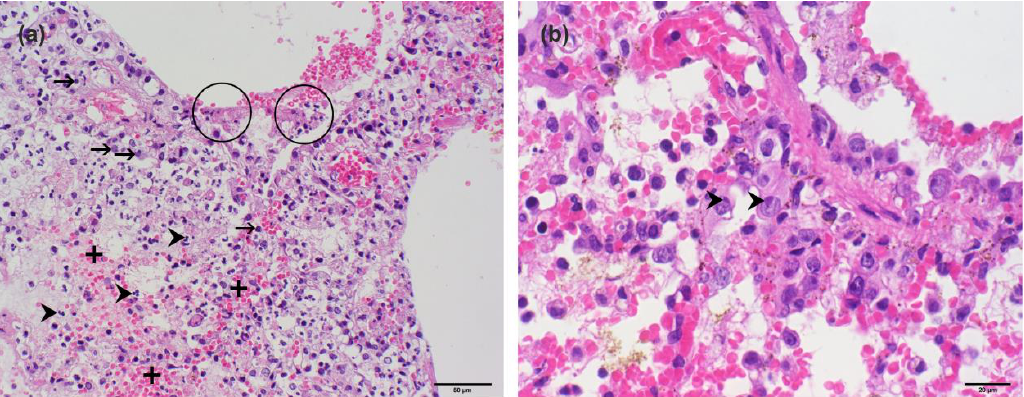
Figure 1. Histopathological findings in the lung of the deceased Sri Lankan Giant squirrel. ( a ) Hemorrhagic-necrotizing pneumonia with group cell necrosis of pneumocytes (circles), acute hemorrhages (plus), and infiltration of neutrophil granulocytes (arrow heads), as well as mononuclear inflammatory cells (arrows); ( b ) eosinophilic intranuclear inclusion bodies in pneumocytes (arrow